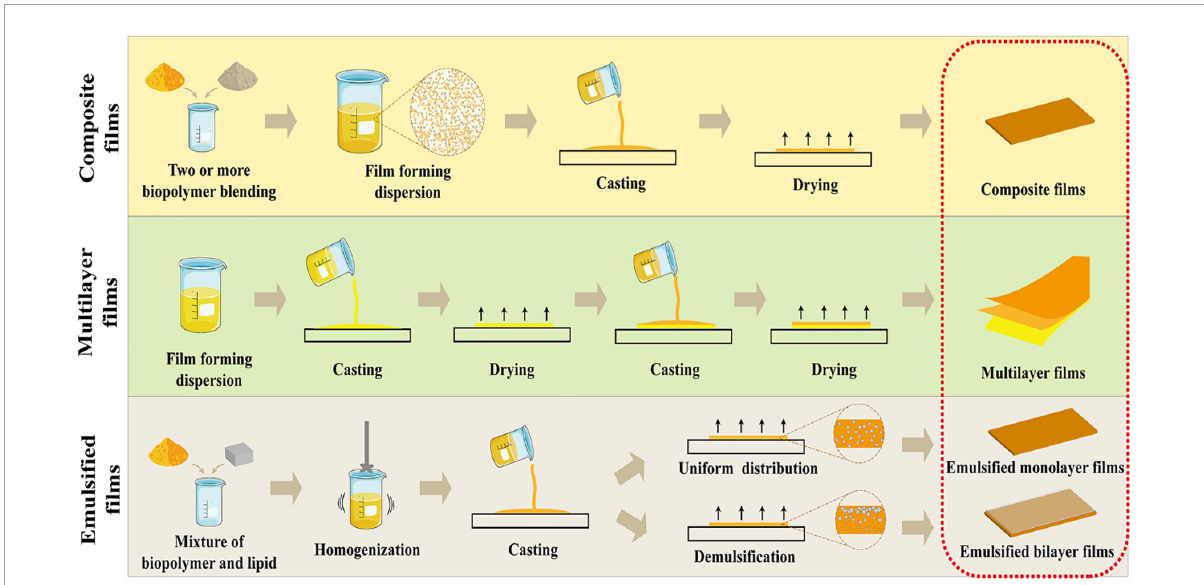
FIGURE3 Schematic illustration of the advanced film forming strategies to fulfill functionality of biopolymer-based films with improved mechanical and functional properties for food packaging